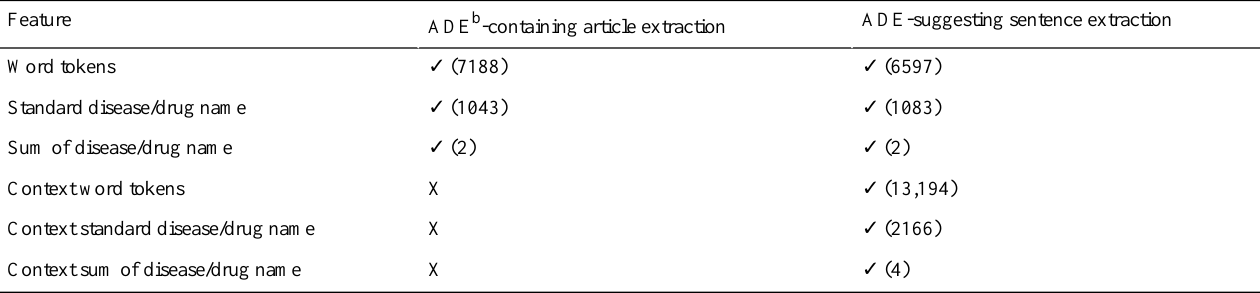
Table 2. Feature set used in ADE-containing article extractions and ADE-suggesting sentence extractions. a